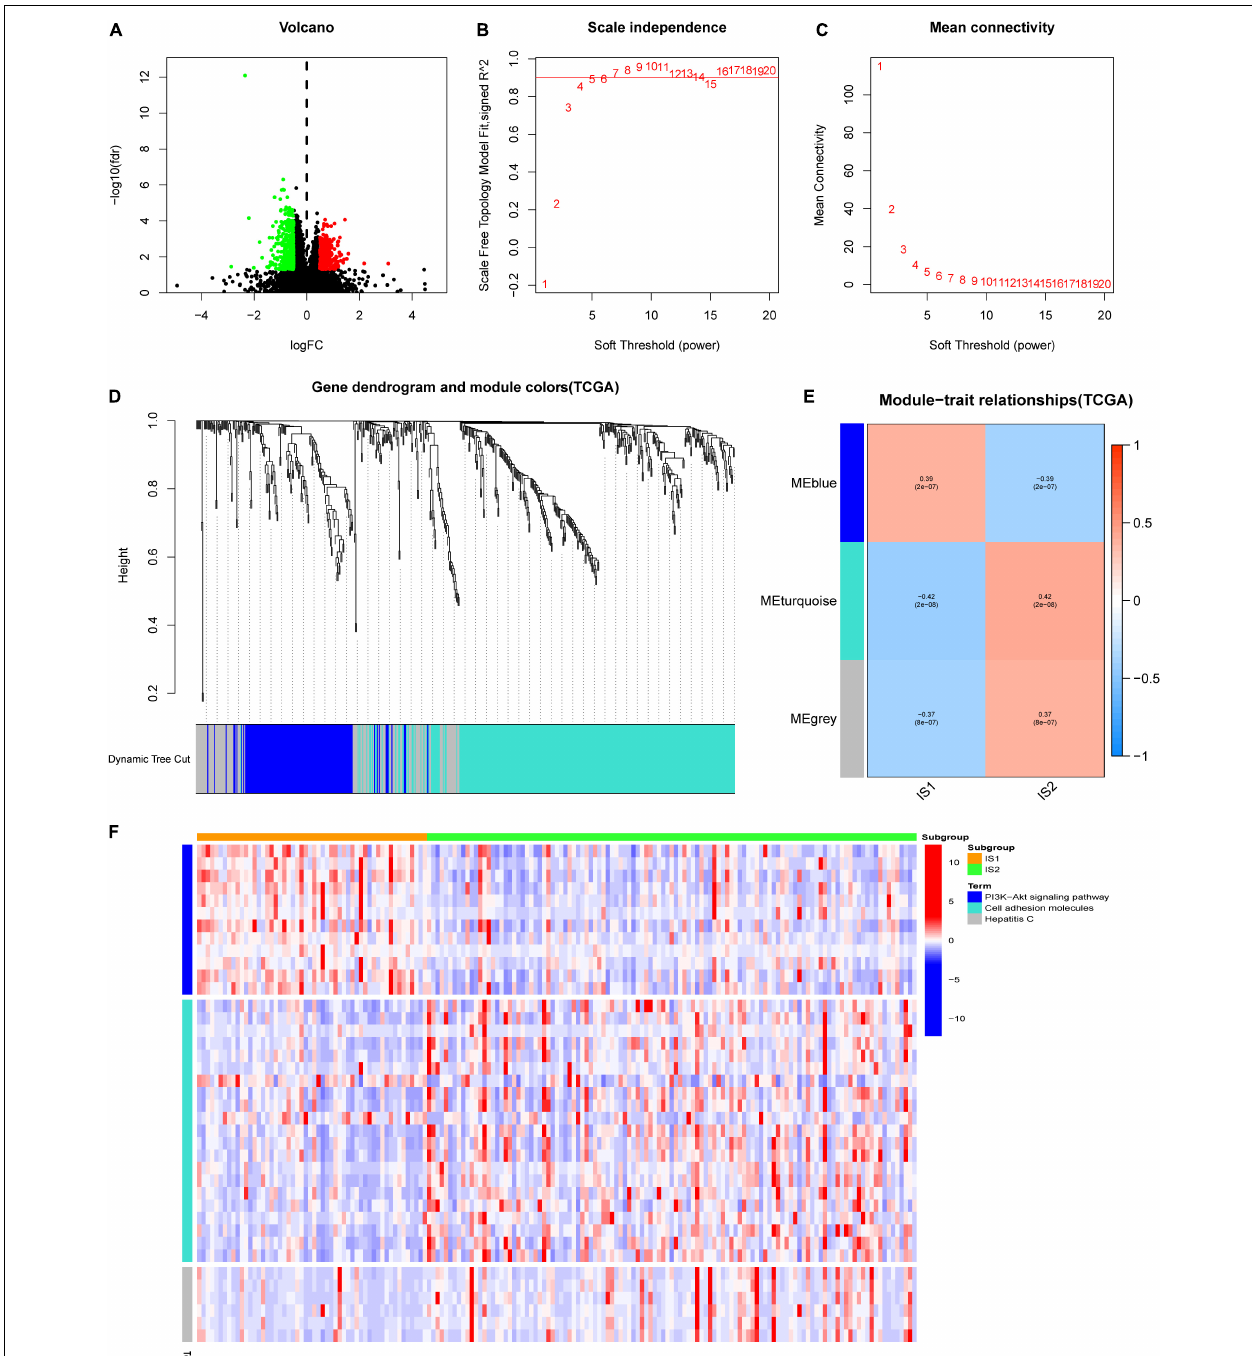
FIGURE 7 | Weighted gene co-expression network analysis (WGCNA) of differential expressed genes (DEGs) between different immune subtypes in TCGA-GBM. (A) The volcano plot showed the differentially expressed genes among IS1 and IS2. The log | FC | > 1 and adjusted P -value < 0.05 were considered significant. The red dot represents the upregulated gene in IS2. Instead, the green dot represents the upregulated gene in IS1. The black dots mean no significant difference among the two groups. (B,C) Scale-free fit index and mean connectivity for various soft-thresholding powers ( β ). (D) DEGs were clustered using hierarchical clustering with a dynamic tree cut and merged based on a dissimilarity measure (1-TOM). (E) Relationship analysis between immune subtypes and modules. Color on the left represents a module, and red represents positive correlation, blue represents negative correlation, the darker the color, the stronger the correlation, and the value in brackets under the correlation coefficient is the calculated p -value. (F) Heatmap showed the expression level of different Kyoto Encyclopedia of Genes and Genomes (KEGG) terms involved DEGs of blue, turquoise, and gray module (MEgray) in IS1 and IS2, heat map colors correspond to the level of mRNA expression as indicated in the color